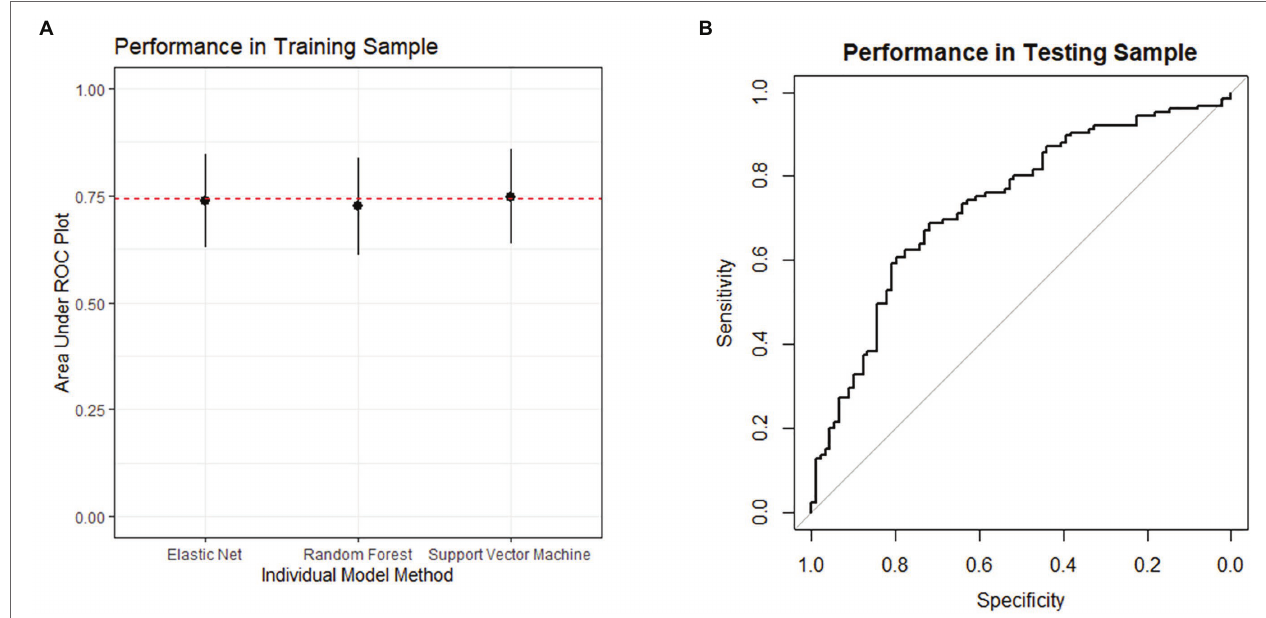
FIGURE 2 | (A) depicts the performance in the training sample during model development. The performance of each model in the algorithm is depicted as the mean area under the receiver operating characteristic plot. The error bars represent the standard deviation. The dashed line represents the performance of the ensemble model. (B) depicts the receiver operating characteristic plot for the model’s performance when applied to the testing sample. The area under the curve is 0.74, and the lower bound of the 95% confidence interval is 0.67.